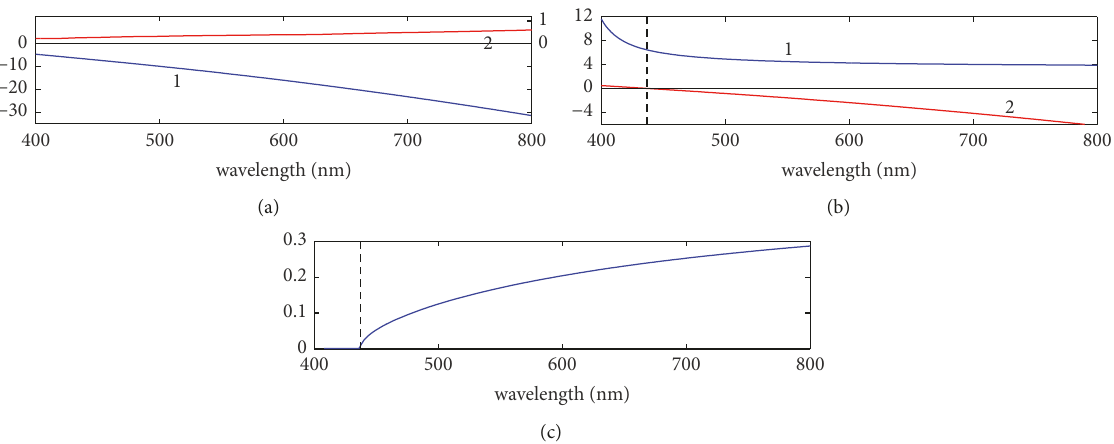
Figure 1: (Color online) (a) the wavelength dependence of real (curve 1) and imaginary (curve 2) parts of the permittivity of silver, 𝜀 𝑀 (notice different scales for Re (𝜀 𝑀 ) and Im (𝜀 𝑀 ) ); (b) the dispersion of dielectric tensor components (real part) 𝜀 ‖ (curve 1) and 𝜀 ⊥ (curve 2) of effective wire medium (silver wires with volume fraction 𝜌 𝑀 = 0.25 in silica host); (c) the normalized critical angle, 𝜙 ∗ /𝜋 as a function of the wavelength. Dashed line marks the transition from common elliptical medium to the hyperbolic one with 𝜀 ‖ 𝜀 ⊥ < 0